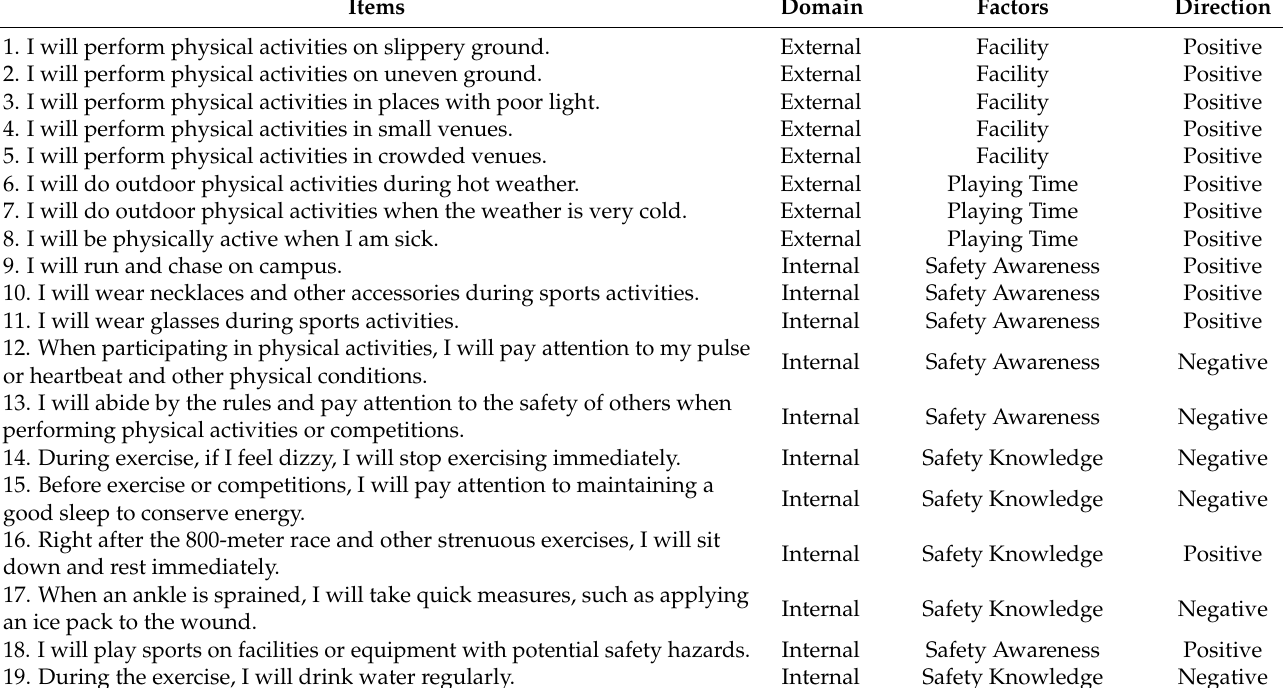
Table 1. Items for Internal and External Factors resulting in School Sports Injuries